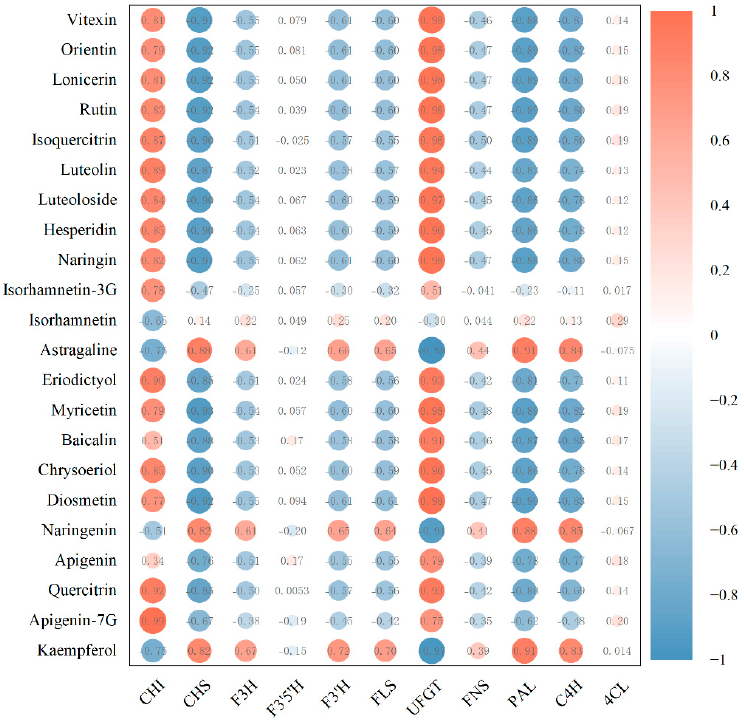
Figure 7. Correlations between flavonoid monomers and gene expression of related enzymes.